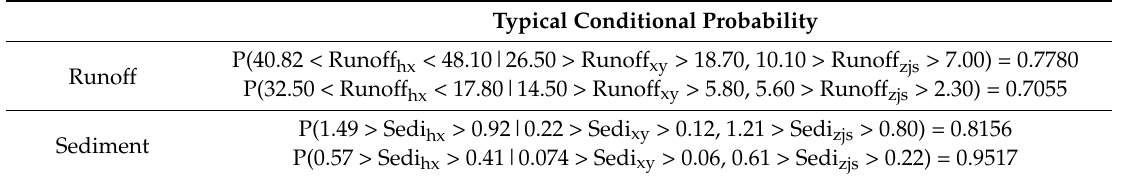
Table 6. Typical conditional